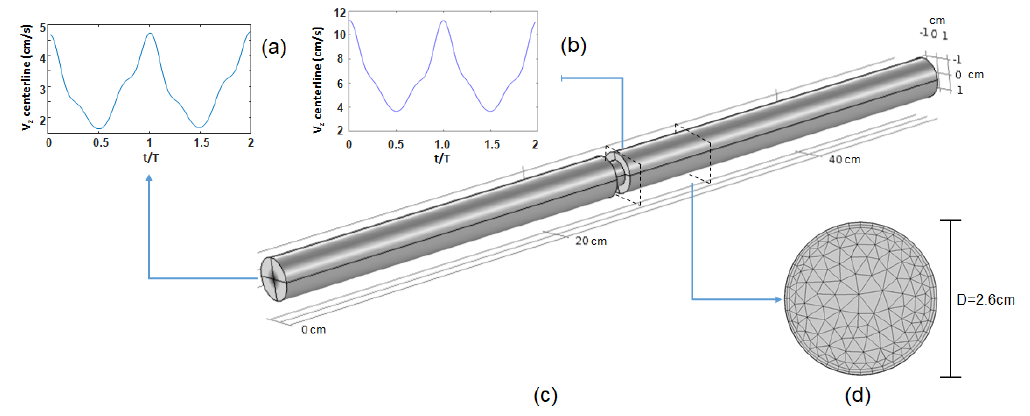
Figure 4: (a) Axial inlet velocity at r = 0; corresponds to Re u = 1187; (b) axial velocity at r = 0 and z = 0; corresponds to ¯ Re = 1106; (c) schematic drawing of the flow development section and the axisymmetric constricted tube; (d) cross sectional view of the